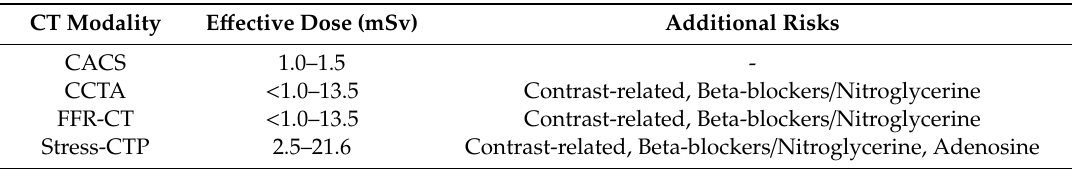
Table 2. Radiation exposure and presumed risk of cardiac computed tomography (CT)